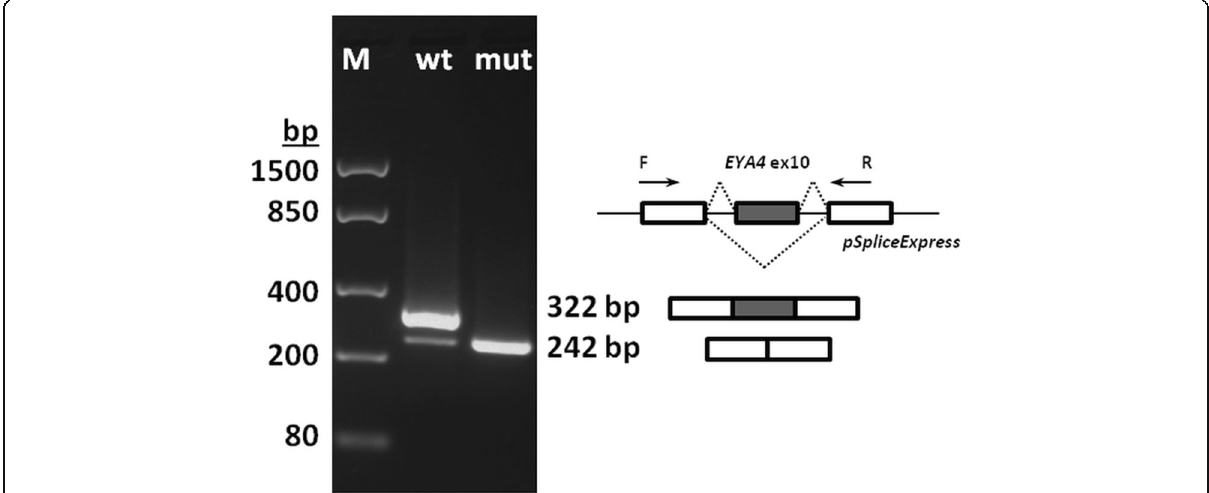
Fig. 5 Mini-gene assay results. Wild-type EYA4 exon 10 (wt) is incorporated into the mature transcript, exon 10 with c.804G > C mutation (mut) is spliced